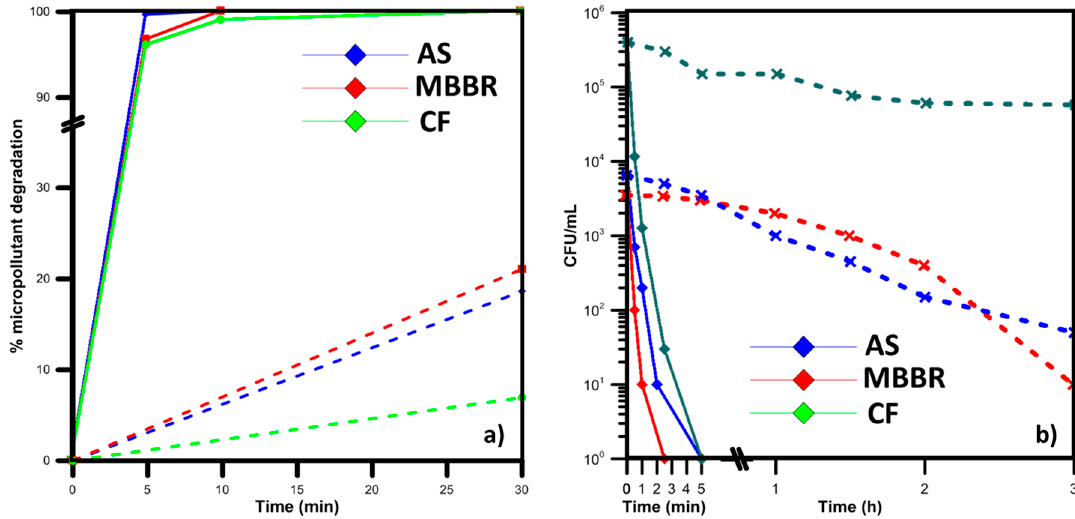
Figure 2. Degradation of chemical and microbiological contaminants in MWW. ( a ) Weighted average removal of seven selected micropollutants by the UV/H 2 O 2 process (ng/L initial MP content and 25 mg/L H 2 O 2 ); and ( b ) reduction of bacteria contained in WW by the UV/H 2 O 2 (continuous trace) and the solar photo-Fenton process (dashed line). The colors correspond to the previous secondary treatment (blue: Activated Sludge, red: Moving Bed BioReactors, green: Coagulation-Flocculation). More details on the micropollutants’ initial content, experimental configuration and wastewater characteristics can be found in [78,79].